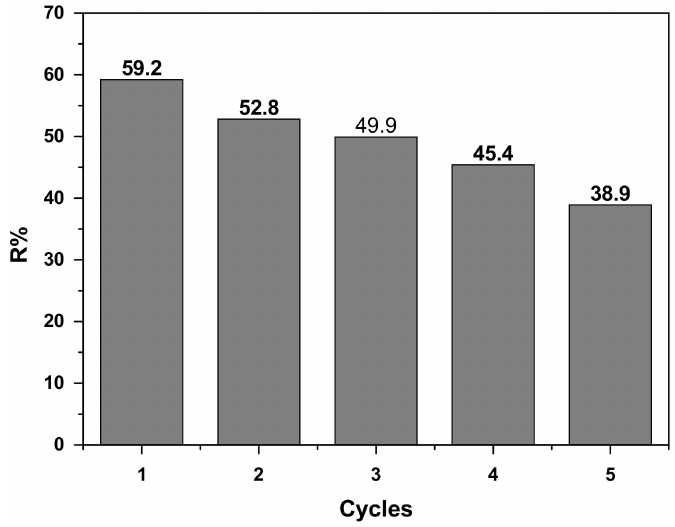
Figure 11. Cr(VI) adsorption on COC-AC-La; initial Cr(VI) concentration 100 µ g/L, solution pH 5, dose 0.2 g/L, T = 22 ± 1 ◦ C, contact time 2 h, for five adsorption–desorption cycles after regeneration at alkalic pH values, by using NaOH